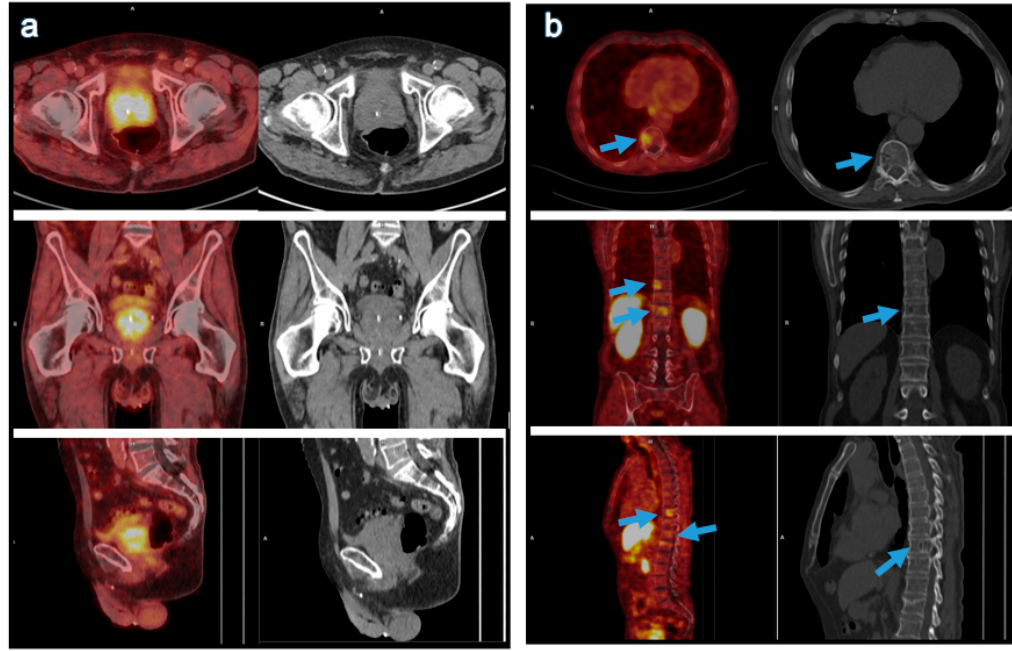
Figure 1. Primary staging of a treatment-naïve, 75-year-old patient with PCa which has metastasized to the bone, using [ 64 Cu]-DOTAGA-PSMA PET–CT. The PSA value at the time of PET–CT was 47 µg/L. ( a ) The PSMA-positive primary tumor (SUVmax apical: 9.5; left base: 8.0). ( b ) The PSMA-positive bone metastases in T10 and T12 (respective SUVmax: 5.3 and 4.6); the arrow in the correlating low-dose CT images point to the metastasis in T10.